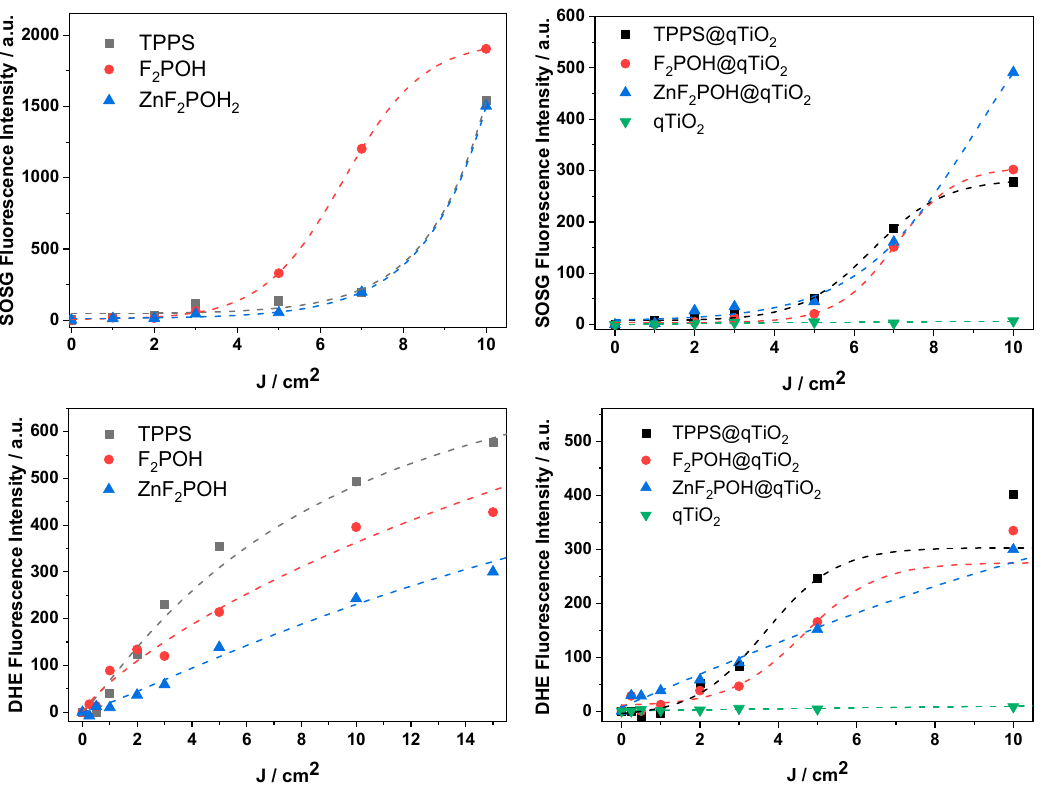
Figure 8. Photogeneration of ROS. Light dose-dependent increase of fluorescence of fluorescent probes (10 µ M): dihydroethidium (DHE), and Singlet Oxygen Sensor Green (SOSG) in the presence of porphyrins and porphyrin-modified qTiO 2 materials irradiated with 420 ± 20 nm LED